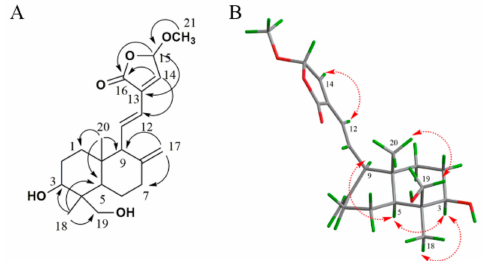
Figure 2. Key HMBC correlations ( A ) and key NOESY correlations ( B ) of AP-1